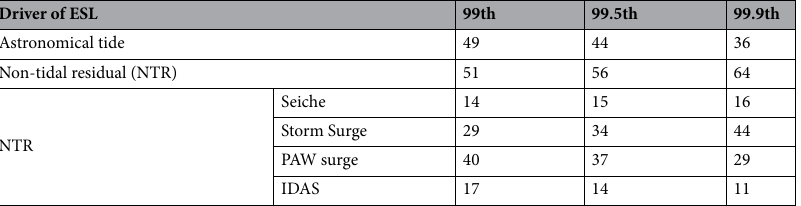
Table 1. Mean contribution (in %) of the different drivers of ESLs defined according to the 99th, 99.5th and 99.9th percentile datasets. Tide and NTR contributions are computed with respect to the total sea level, while the other non-tidal contributions are computed with respect to NTR.